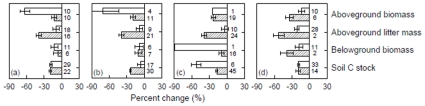
Percent change of ecosystem C pools from natural forests to plantations with two different groups in relation to stand age (a), stand type (b and c), and tree origin (d).Bars represented mean±95% CI. Values near each bar indicates the number of cases synthesized. Note: open bar- (a) <25 years, (b) broadleaved, (c) deciduous, and (d) native; hatched bar- (a) ≥25 years, (b) coniferous, (c) evergreen, and (d) exotic.